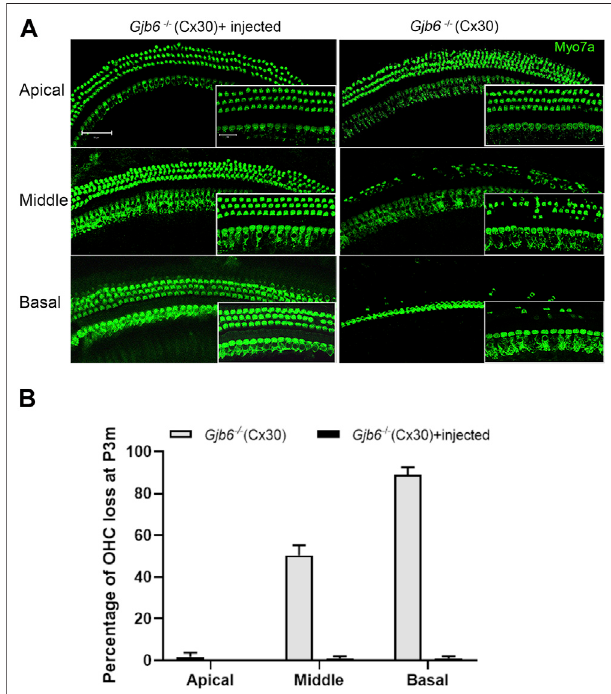
FIGURE 3 | Injection of AAV1-CB7- Gjb2 improved OHC survival in Gjb6 − / − mice. (A) Comparison of the loss of OHCs between un-injected and injected ears in Gjb6 − / − mice at 3 months post injection. Images were obtained from whole-mount cochlear samples. Insets are magni fi ed images. (B) Quanti fi cations ofthepercentage ofOHCloss(normalizedtoage- matched WT controls) in the apical, middle and base turns of un-injected Gjb6 − / − mice and Gjb6 − / − mice injected with AAV1-CB7- Gjb2 examined at 3 months post-injection. Error bars in (B) represent standard deviation of the mean ( n = 3 for each group). Myo7a, Myosin 7A.Scale bar: 50 µm (low magni fi cation), 20 µm (high magni fi